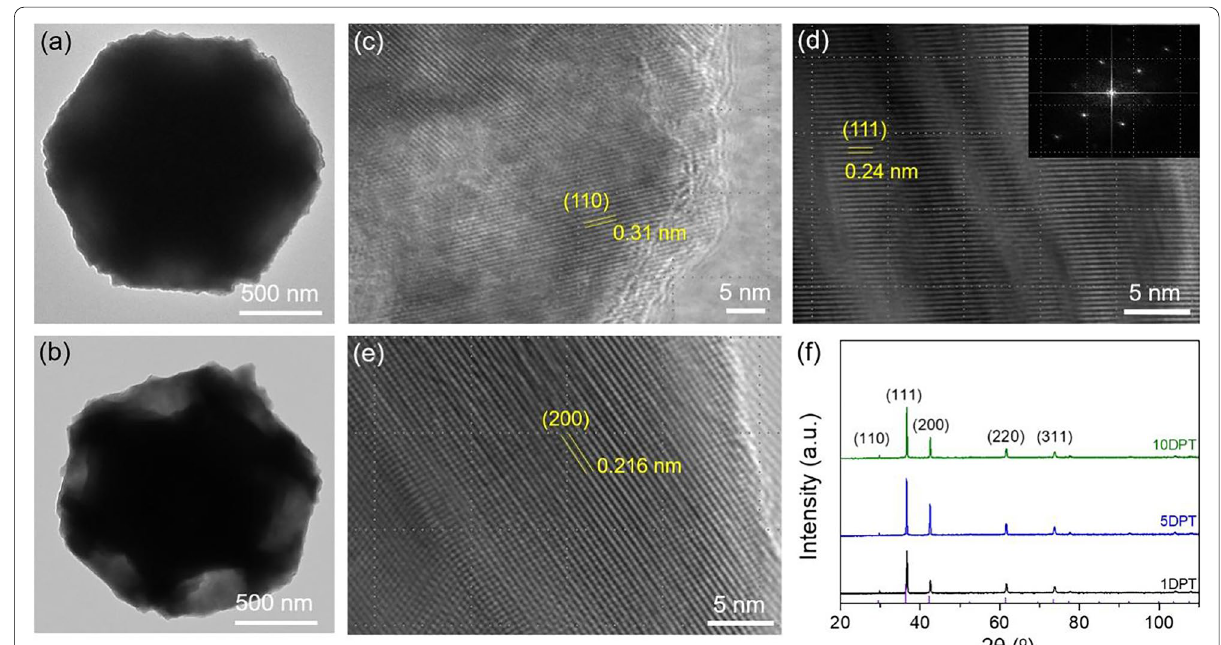
Fig. 2 a , b TEM images of 5DPT and 10DPT NCs. c - e HRTEM images of 5DPT NCs: ( c ) {110}; ( d ) {111}; ( e ) {200} facets. f XRD patterns of 1DPT, 5DPT and 10DPT